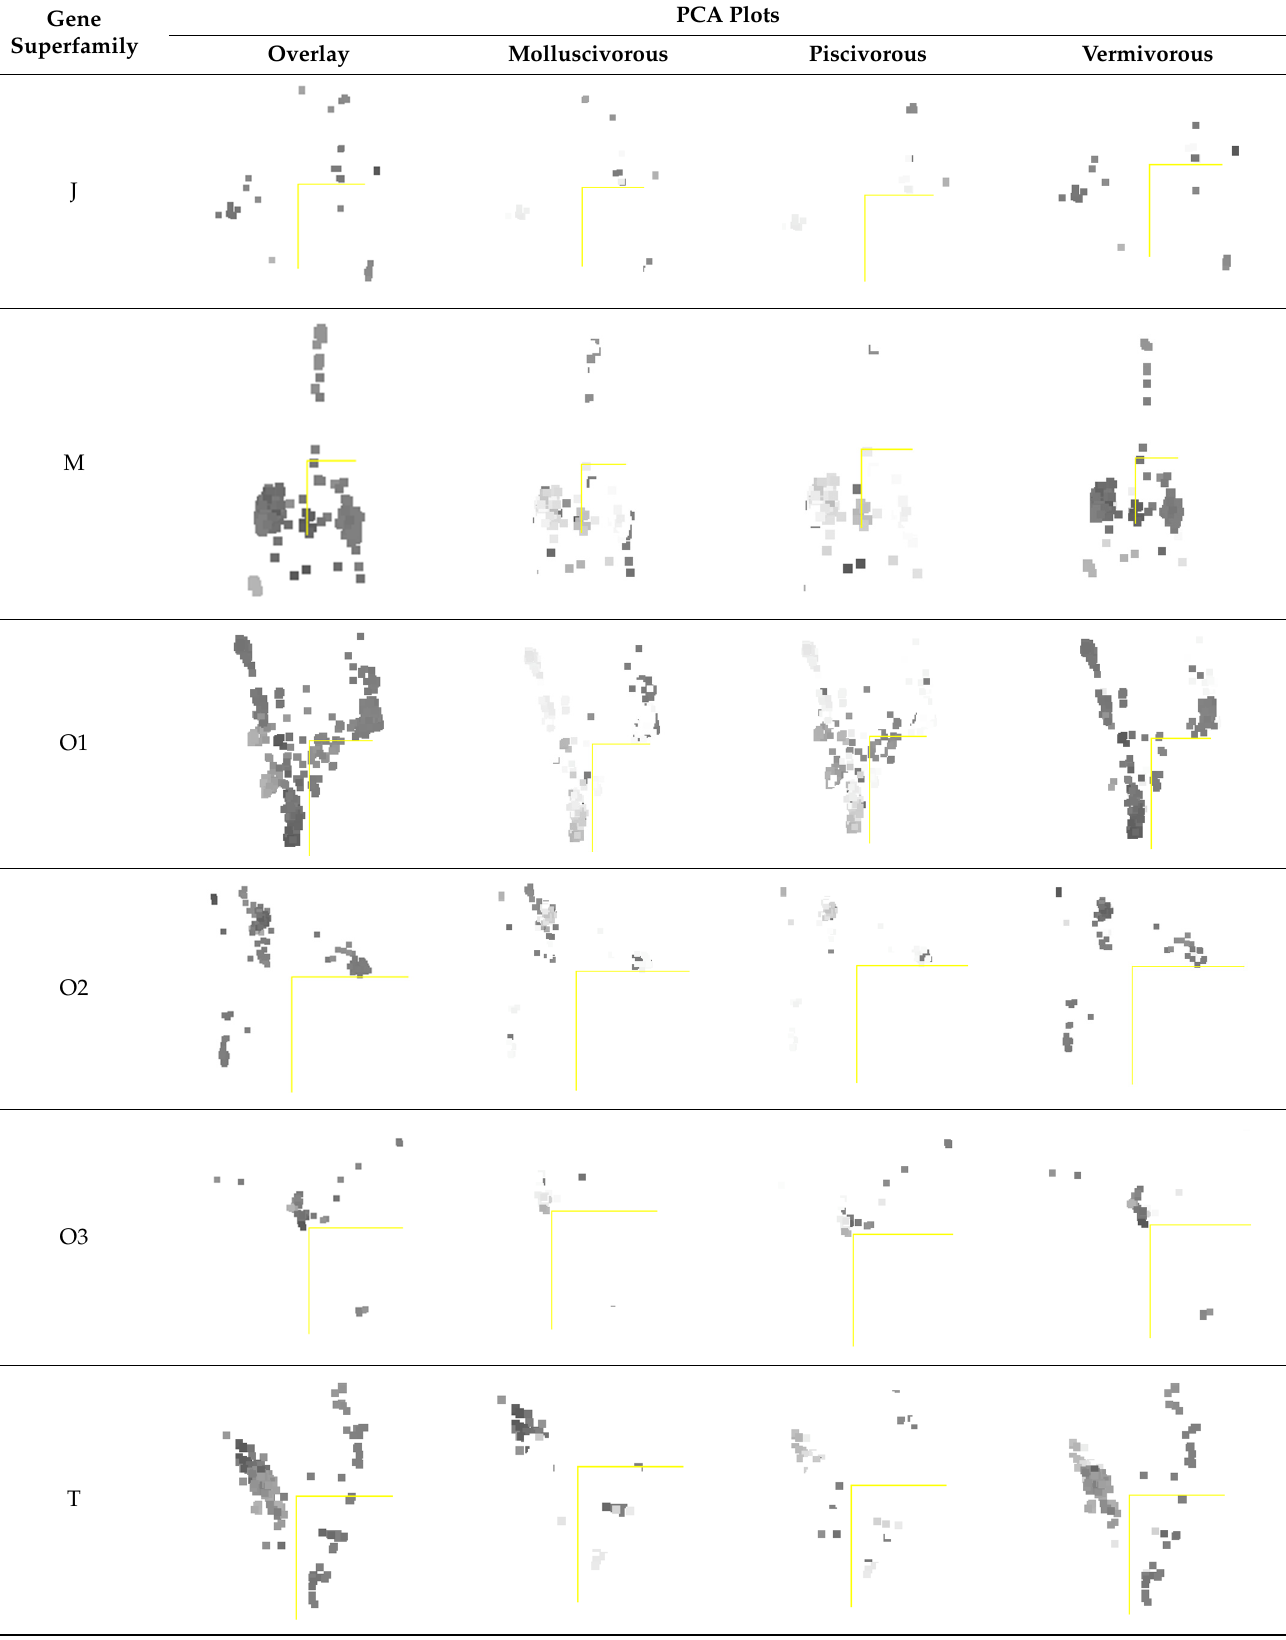
Table A2. Neighbor-joining trees for small sample sizes.